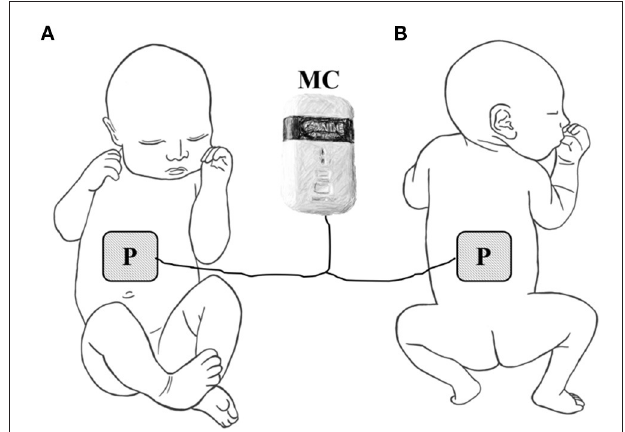
FIGURE 1 | Placement of electrode for microcurrent therapy on (A) the front side of the infant or (B) the back of the infant. P, electrode patch, MC, microcurrent generator.